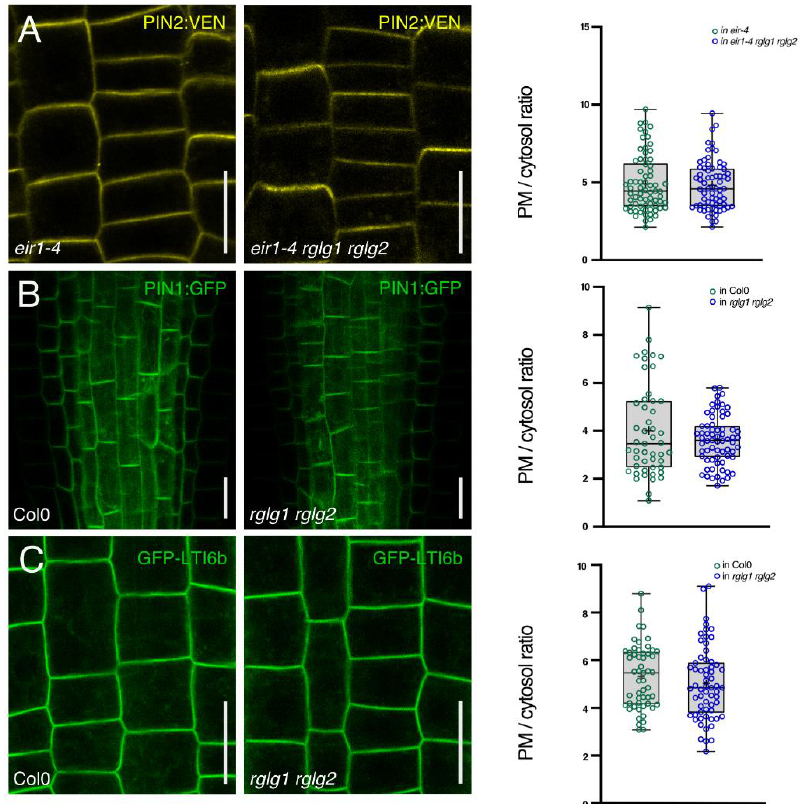
Figure 5. ( A ) PIN2:VEN (yellow) in eir1-4 (left panel) or eir1-4 rglg1 rglg2 (middle panel) root meristem cells at 5 days after germination. Right panel: Quantification of PIN2:VEN signals at the plasma membrane (PM) and in the cytosol in eir1-4 or eir1-4 rglg1 rglg2 root meristem epidermis cells ( n = 65–70). ( B ) PIN1:GFP (green) in Col0 (left panel) or rglg1 rglg2 (middle panel) root meristem stele cells at 5 days after germination. Right panel: Quantification of PIN1:GFP signals at the plasma membrane (PM) and in the cytosol in Col0 or rglg1 rglg2 root meristem stele cells ( n = 60–70). ( C ) GFP-LTI6b (green) in Col0 (left panel) or rglg1 rglg2 (middle panel) root meristem epidermis cells at 5 days after germination. Right panel: Quantification of GFP-LTI6b signals at the plasma membrane (PM) and in the cytosol in Col0 or rglg1 rglg2 root meristem epidermis cells ( n = 60–70). Circles represent single data points; boxes: first and third quartiles; center line: median; ‘+’: mean value. Two-tailed t -test was employed to determine statistical significance. There was no significant difference found. Size bars: 10 µ